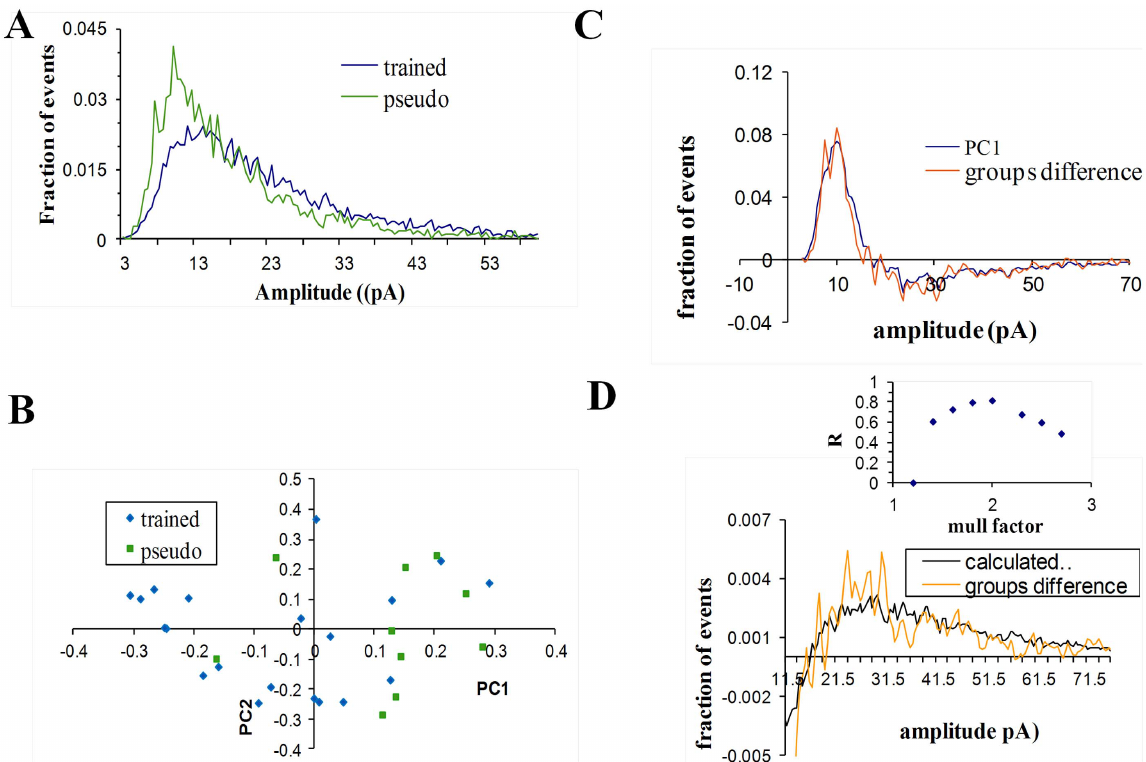
Figure 5. The learning-induced modulation of the inhibitory unitary synaptic events amplitude is dominated by a single process in which the events amplitude was doubled. A. For each neuron an amplitude distribution curve was reconstructed from the mIPSC’s amplitudes and was normalized (data taken form [17]). Averaged amplitude histograms, were calculated for all neurons from the three groups. Notably, a significant portion of events in the trained group are of higher values. B. For each cell the weight for the first component (X-axis) was drawn against its weight for the second component (Y-axis). Only the weights of the first component are significantly different between groups. C. The curve calculated by subtracting the averaged pseudo amplitude distribution curve from the averaged trained amplitude distribution curve (orange) match the first component calculated by PCA (black). D. For each multiplication factor a different curve that describes the difference between groups assuming a multiplication model was calculated. The calculated curve assuming multiplication factor of 2 (black) matched the curve that describes the main difference between groups (orange). Inset: the correlation coefficient was calculated for each multiplication factor (for calculation of R only amplitudes . 13pA were used, since at lower amplitudes, multiplication factors bigger than two requires unavailable data in amplitudes , 6pA, see Methods).